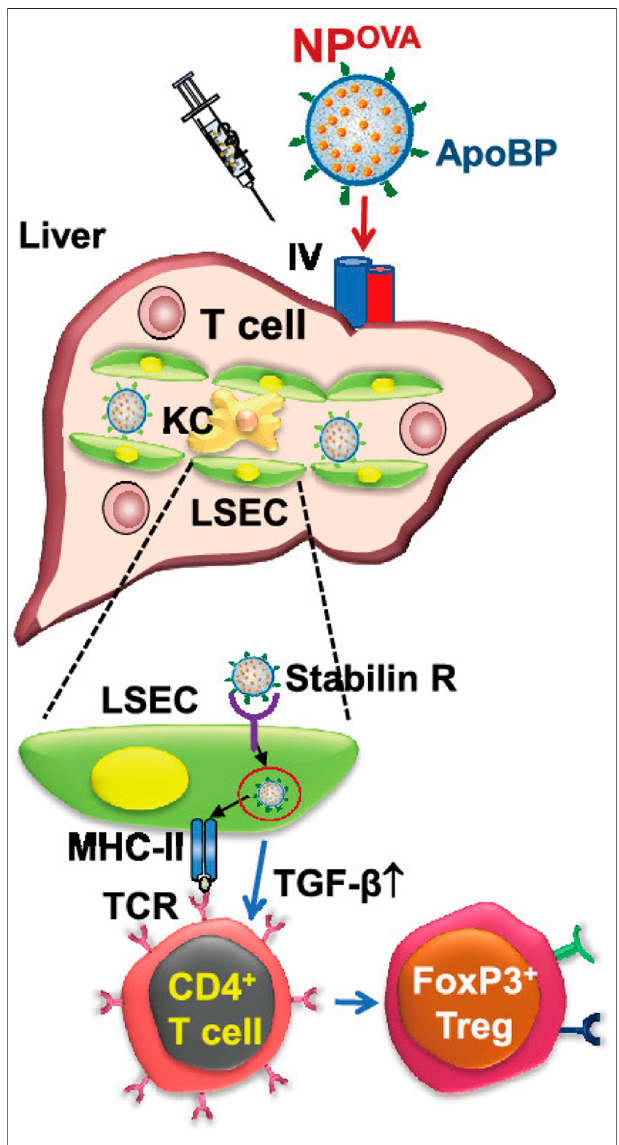
FIGURE 5 | Schematic diagram of the working model for liver-targeting tolerogenic nanoparticles. NPs attached ApoBP ligand delivering the antigens are epitopes to LSECs in the liver through endocytic uptake. Antigen processing and presentation to naive T-cells could generate Foxp3 + Tregs, which are recruited to the site of pathology, where they exert immunosuppressive effects (Liu et al.,